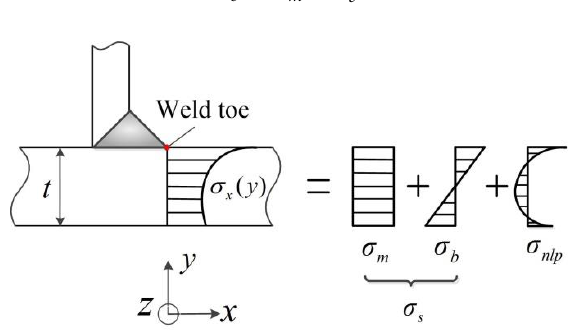
Figure 2. Stress distribution and decomposition at the weld toe section.